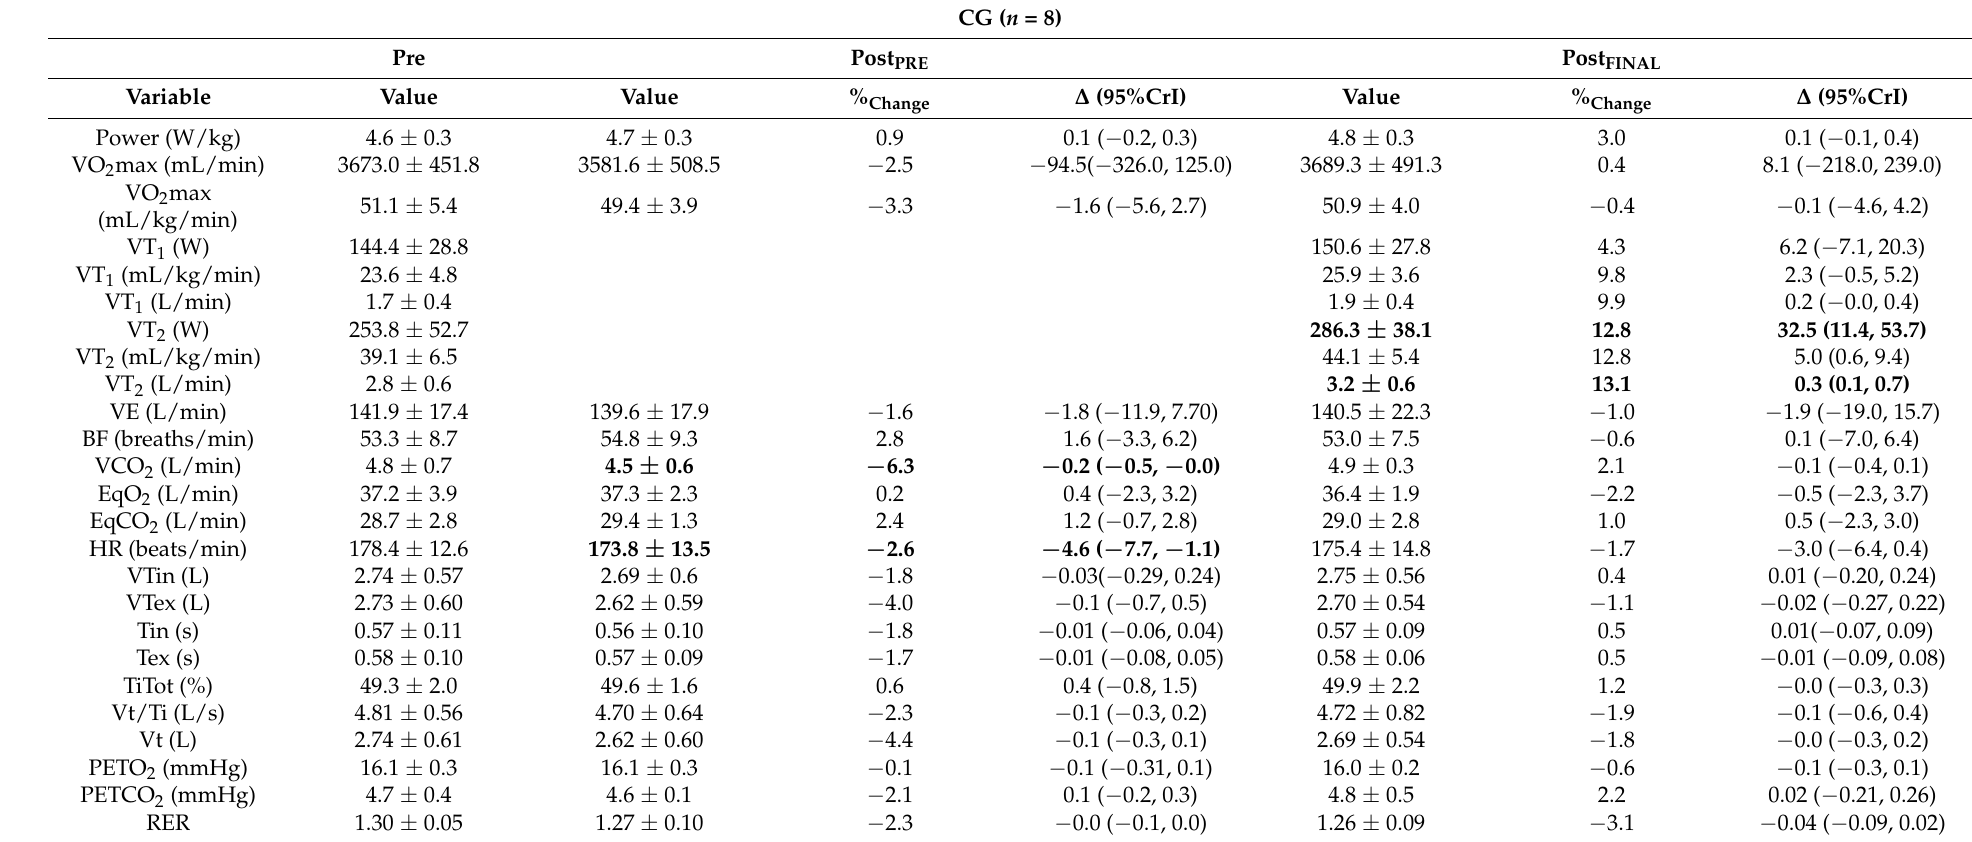
Table 3. Average of the maximum value obtained by the control group (CG) in each variable at the pre-training test (Pre-Value), value obtained in the post-training test at the same moment that the maximum in the pre-training test was obtained (Post PRE -Value), and maximum obtained at the post-training test (Post FINAL -Value). Percentage of change (% Change ), increment ( ∆ ), and 95% HDI are reported from Pre to Post PRE and from Pre to Post FINAL